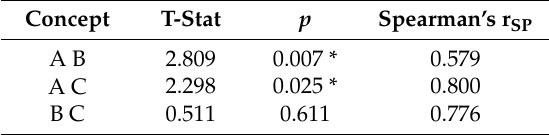
Table 4. Inferential statistics of satisfying scale with Connover’s post-hoc test and Spearman’s r.